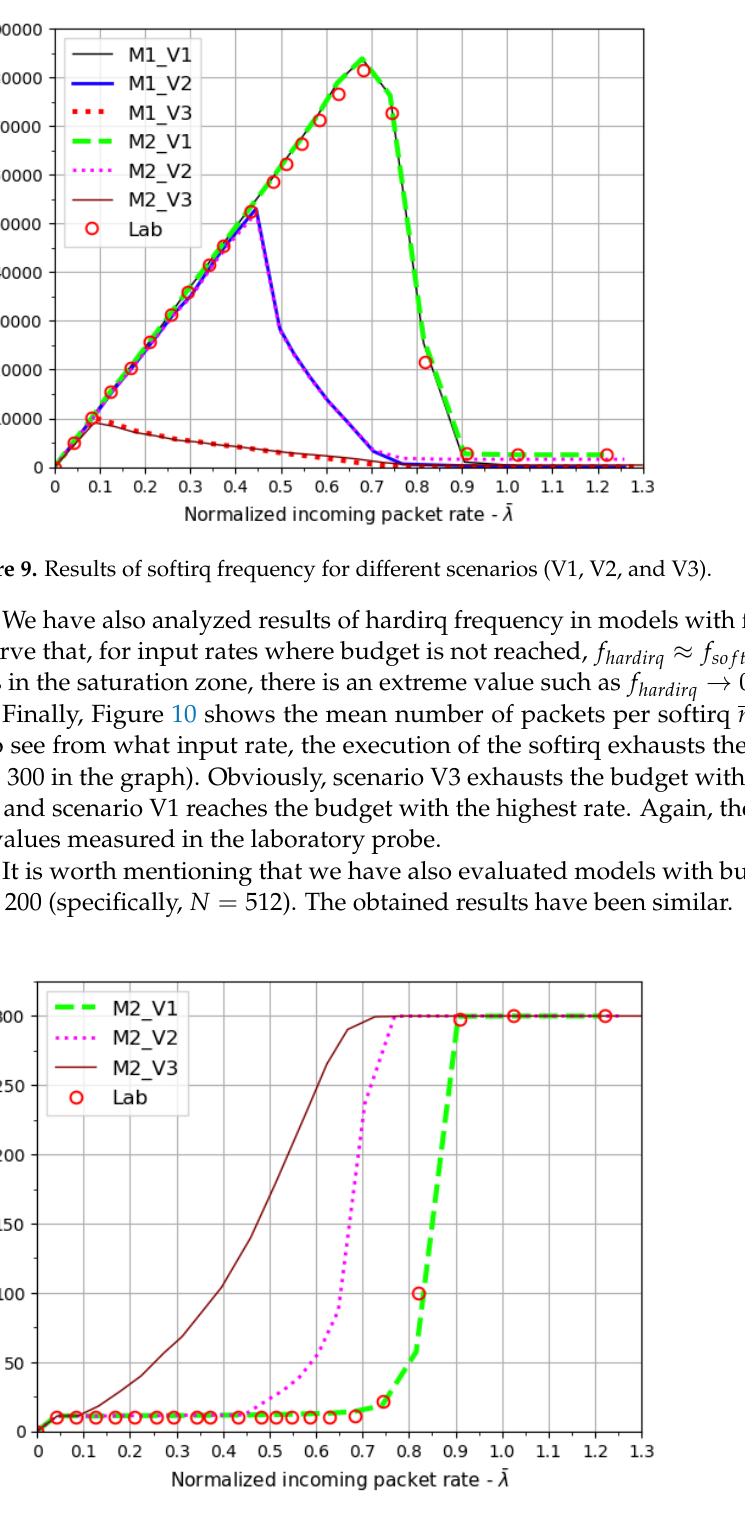
Figure 10. Results of mean number of packets in softirq for different scenarios (V1, V2, and